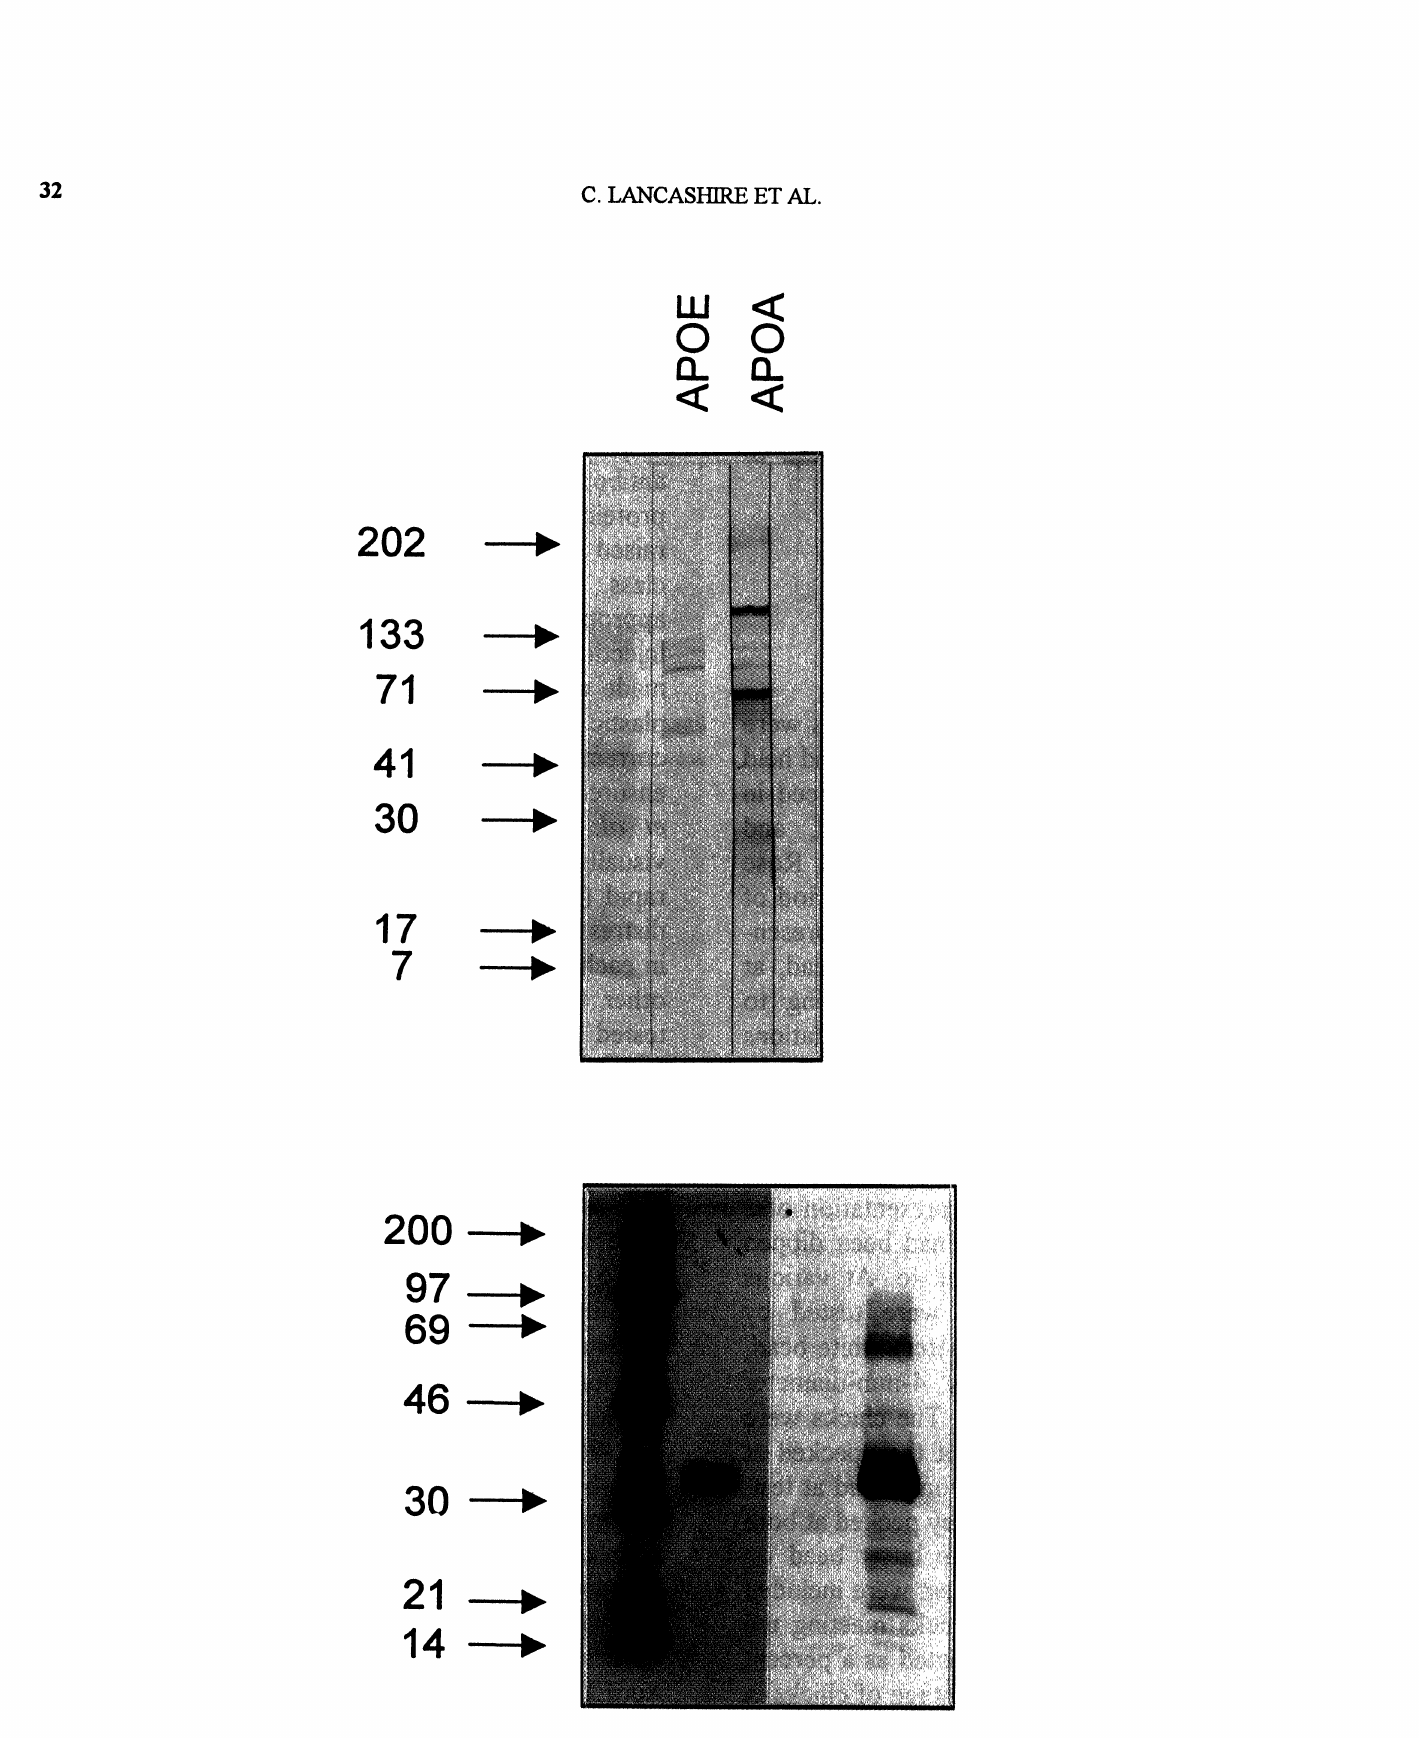
chicken 3 lag f authentic human